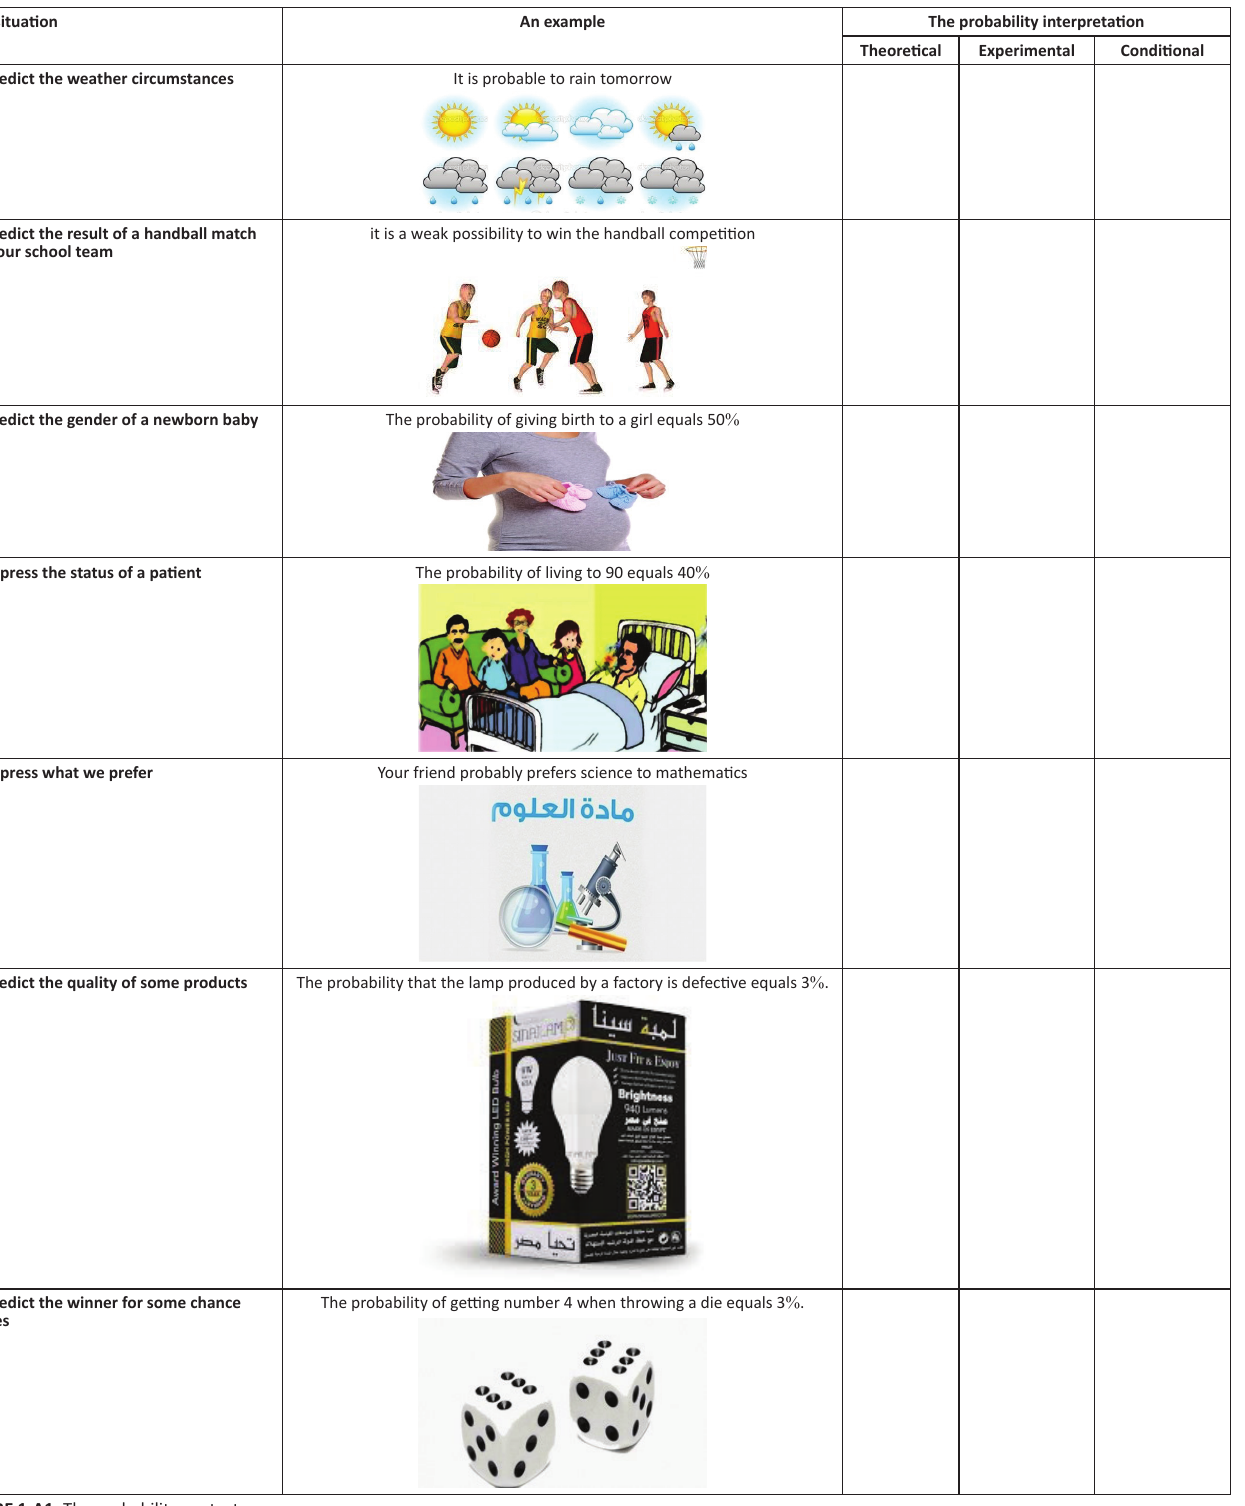
FIGURE 1-A1: The probability contexts